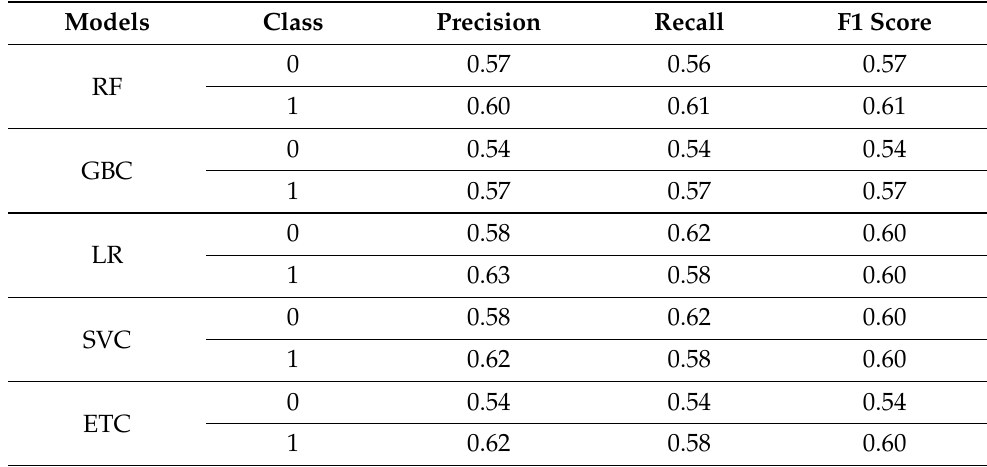
Table 10. Per-class accuracy of LR and SVM models.